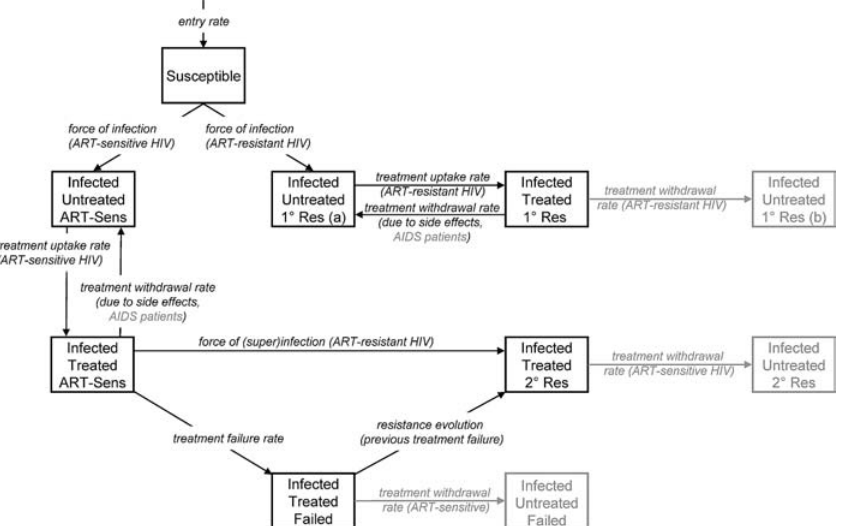
Figure 1. Schematic Illustration of the Structure of the HIV Transmission Model For clarity, stages of infection (primary infection, incubation, pre-AIDS, and AIDS) and death rates are not shown. ‘‘ 1 8 Res ’’ denotes those with primary (transmitted) resistance, while ‘‘ 2 8 Res ’’ denotes those with secondary (acquired) resistance. ‘‘ ART-Sens ’’ denotes people infected with ART-sensitive virus. Treatment withdrawal, used in some scenarios, is shown in grey. DOI: